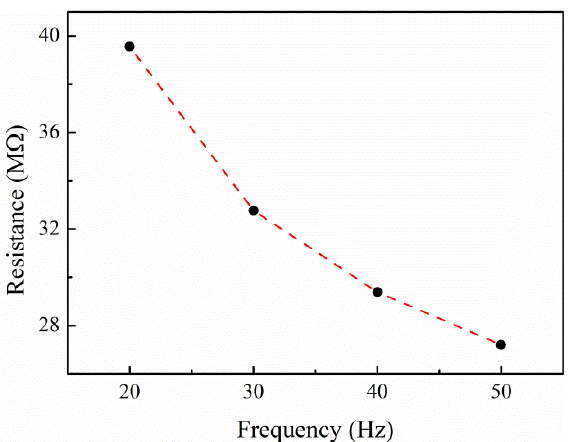
Figure A1. The change in resistance of the PDLC depends on the frequency of the voltage applied.